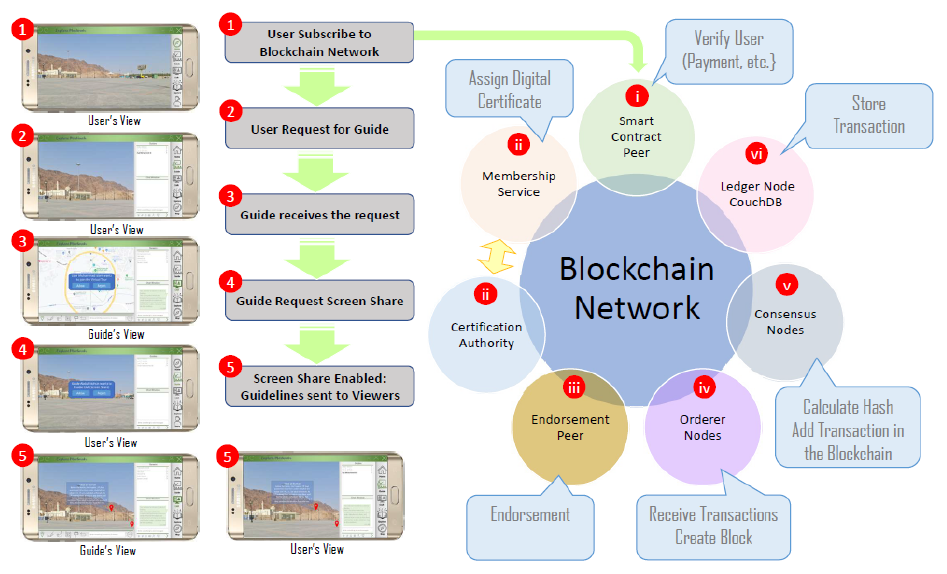
Figure 4. Integrity aware real example of Collaborative AR with